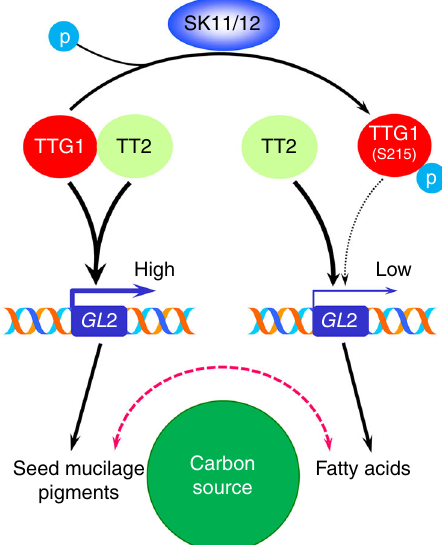
Fig. 8 Site-speci fi c phosphorylation of TTG1 by SK11/SK12 regulates carbon fl ow in Arabidopsis seeds. During seed development, TT2 interacts with unphosphorylated TTG1 and facilitates recruitment of TTG1 to the GL2 locus, thus upregulating GL2 expression. This promotes the formation of seed mucilage and fl avonoid pigments. In contrast, two GSK3-like kinases, SK11 and SK12 , interact with TTG1 and speci fi cally phosphorylate TTG1 at Ser 215. This abolishes TTG1 interaction with TT2, which compromises TTG1 binding to GL2 , thus downregulating GL2 expression to promote biosynthesis of fatty acids in seeds. Therefore, site-speci fi c phosphorylation of TTG1 by SK11/SK12 speci fi cally modulates the direction of carbon fl ow to either formation of seed mucilage and fl avonoid pigments or synthesis